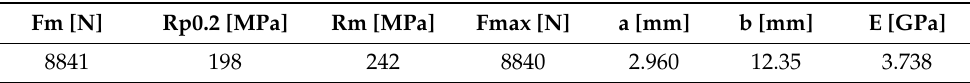
Table 2. Physical-mechanical properties according to